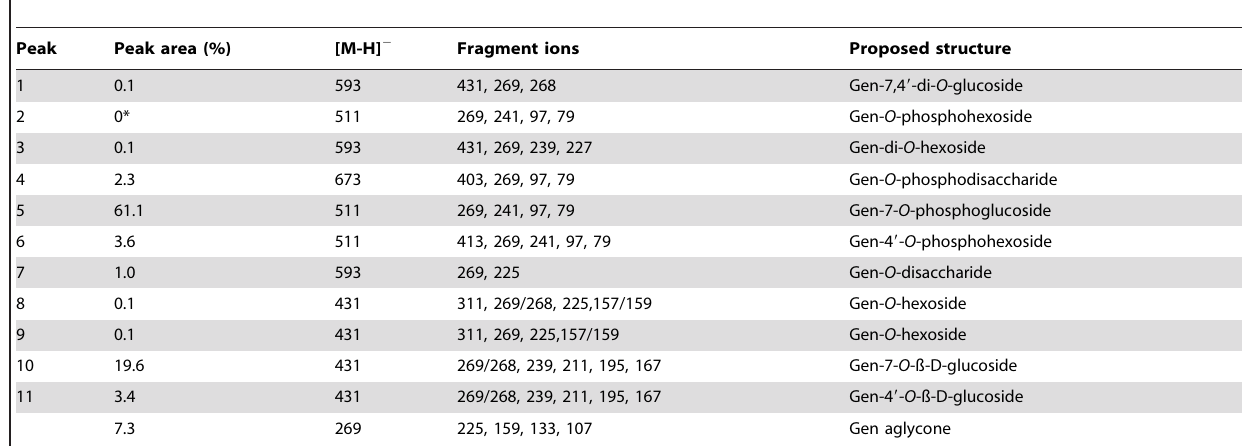
Table 2. Experimental data and proposed structures of the metabolites detected after exposure of C. elegans to genistein for 48 h.